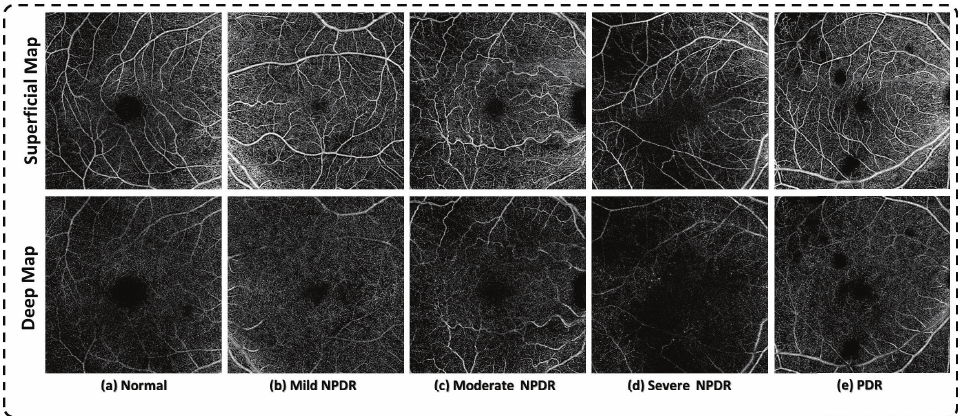
Figure 3. DR progression. A progressive reduction of vessel density with the advancement of the stage of